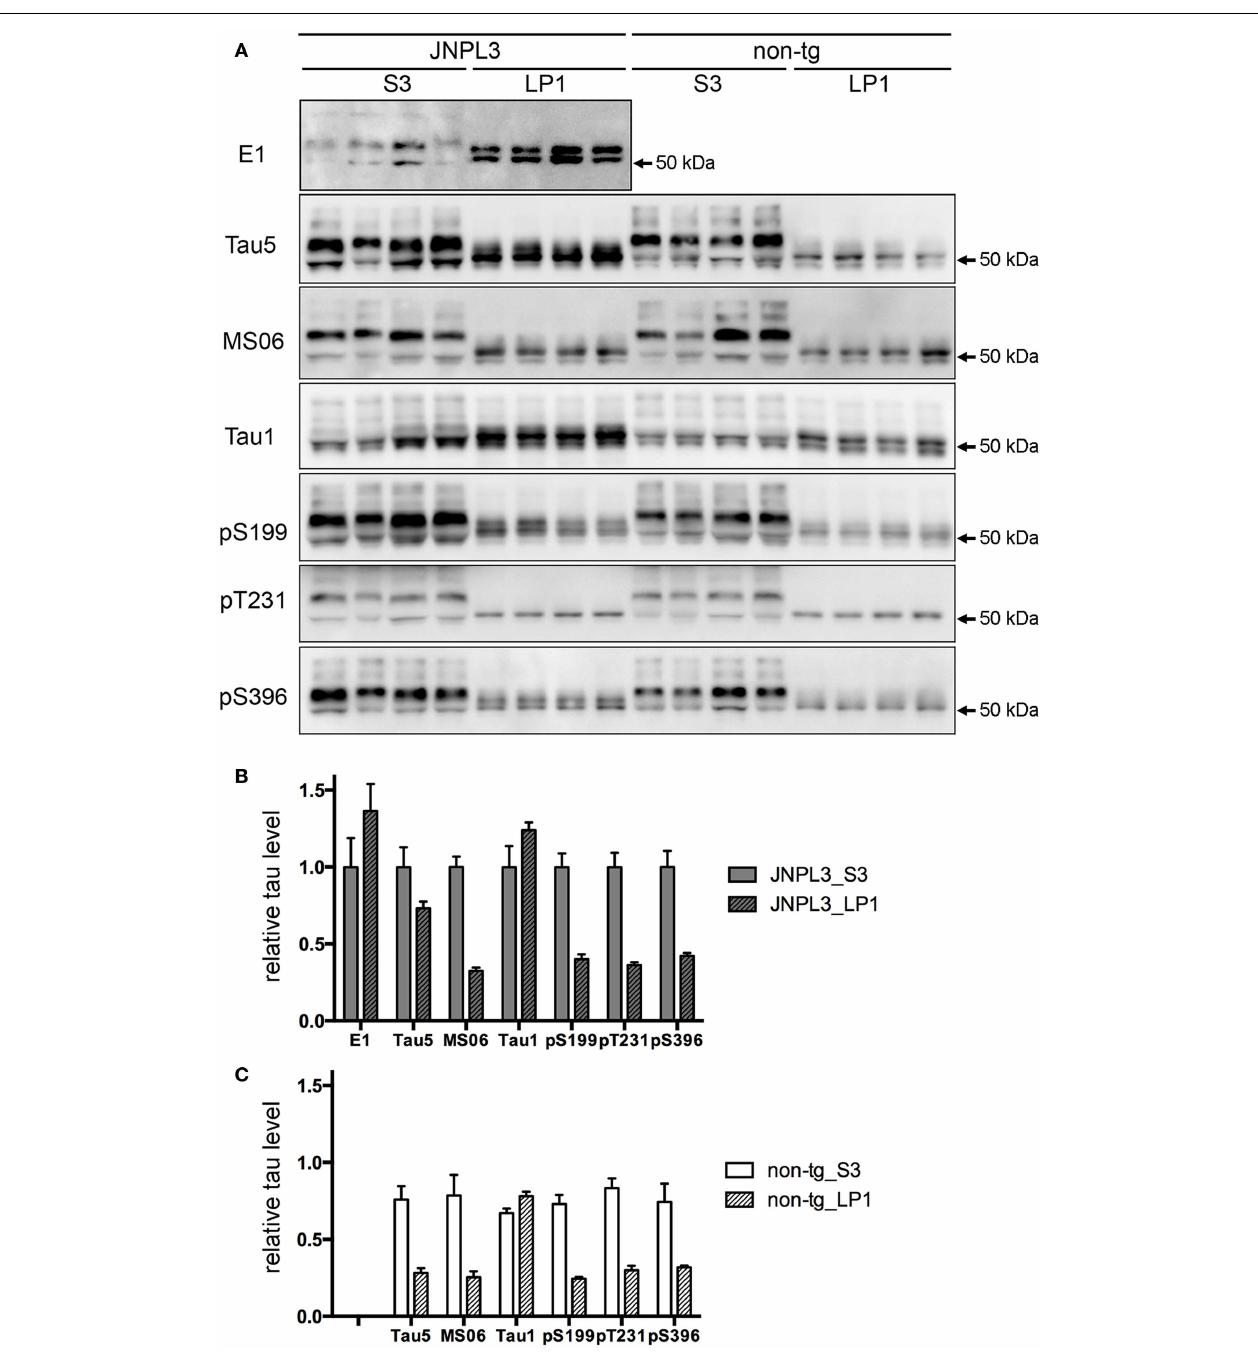
MS06,Tau1, pS199, pT231, and pS396 antibodies. (B,C) The relative ratio of tau protein between S3 and LP1 fractions from JNPL3 (B) and non-tg (C) mice was measured ( n = 4 each). Results are expressed as mean ± SEM.The mean value of tau protein in S3 fraction from JNPL3 mice was normalized to